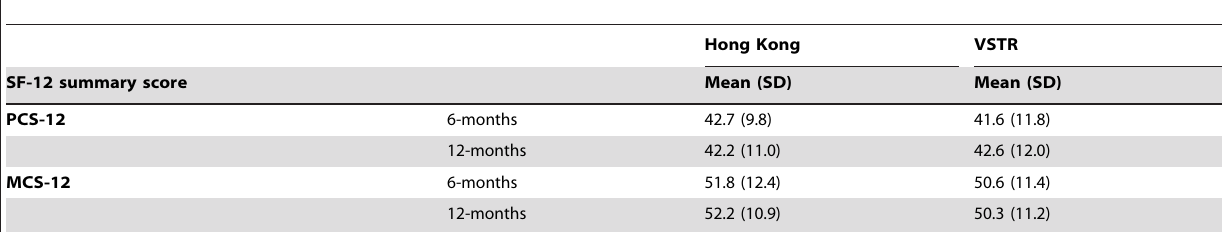
Table 5. Health-related quality of life of Hong Kong and Victorian major trauma patients (SF-12 summary scores).